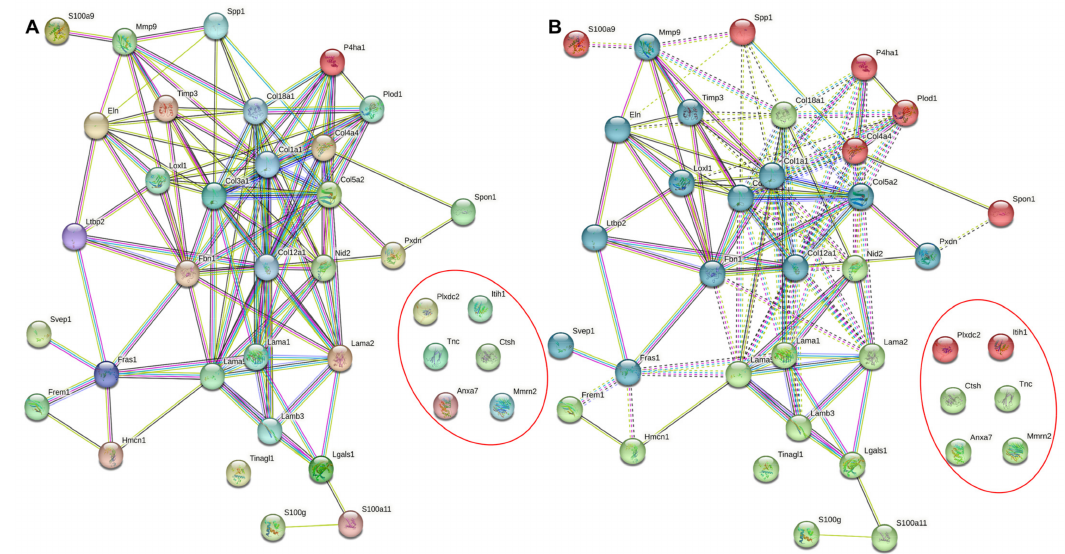
Figure 1. STRING database network analysis of rhythmic mouse ECM and ECM-associated protein targets. ( A ) STRING DB analysis without clustering. ( B ) STRING DB analysis with K- means clustering revealed network contains 37 nodes, 116 edges, an average local clustering coef- ficient of 0.506, and a PPI enrichment p -value < 1.0e-16. The confidence score threshold was set as 0.4 (medium) for the analysis. Coloring in Figure 2A holds no significant meaning while coloring in Figure 2B (red, green, blue) represent clusters of proteins that are similar based on a machine-learning algorithm. The circled proteins (not connected) are similar enough to be clustered in the network but have not shown any evidence of association. The lines or edges between protein nodes represent evidence of association characterized by color: fusion (red), neighborhood (green), co-occurrence (blue), experimental (purple), text mining (yellow), database (light blue), and co-expression (black). Functional enrichment in the network specific to the top 5 biological processes, molecular functions, and cellular components including KEGG pathways are summarized in Table 2.